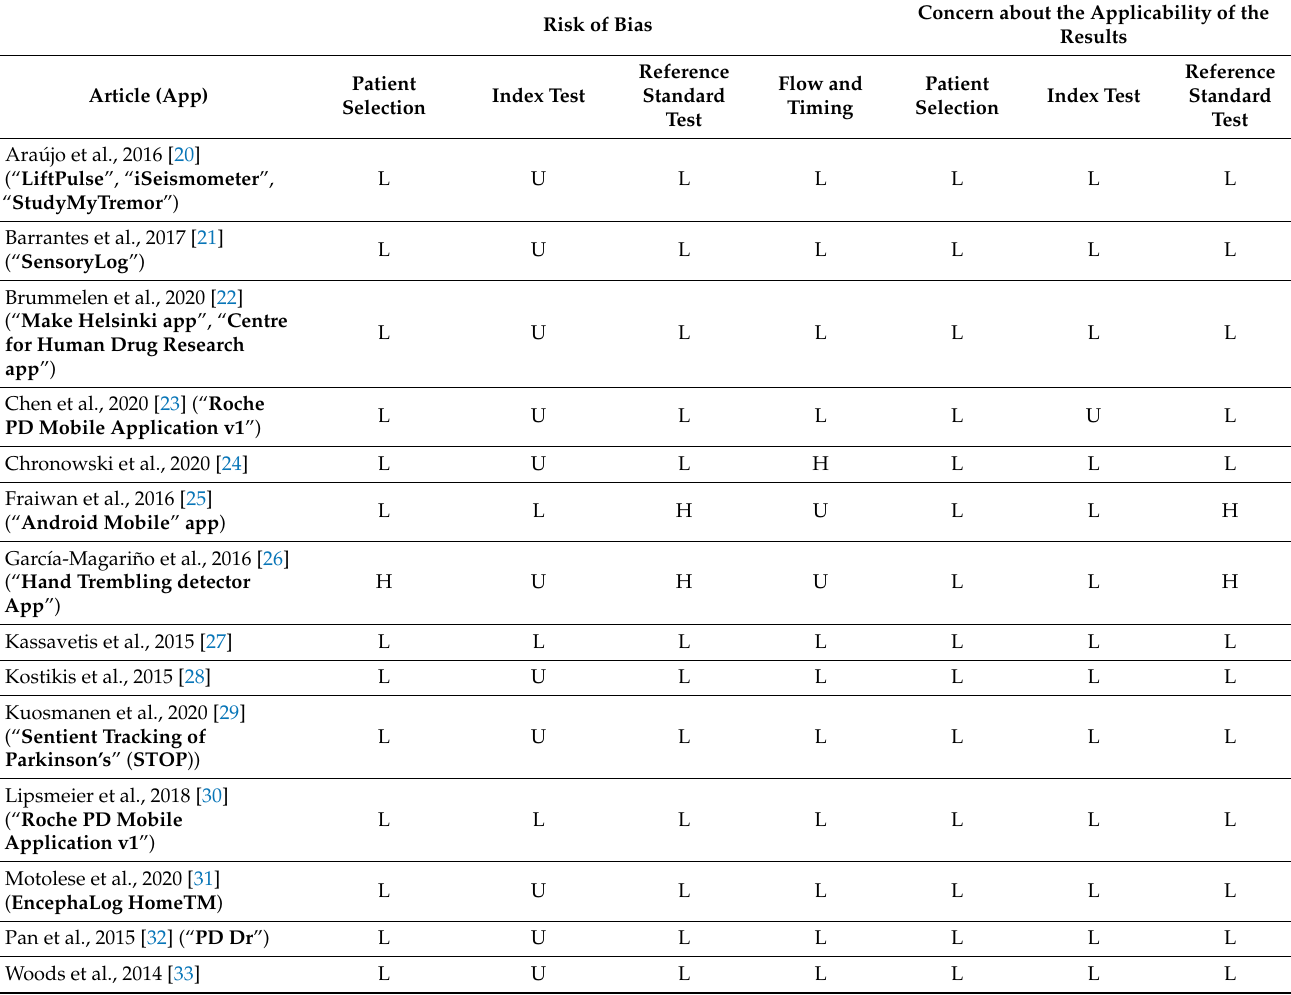
Table 4. Risk of bias of selected articles.